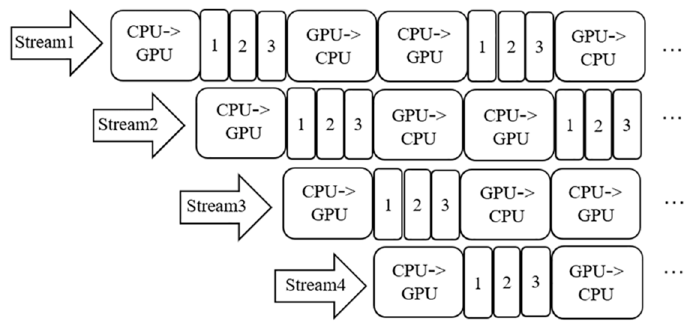
Figure 2. Asynchronous streaming range compression.